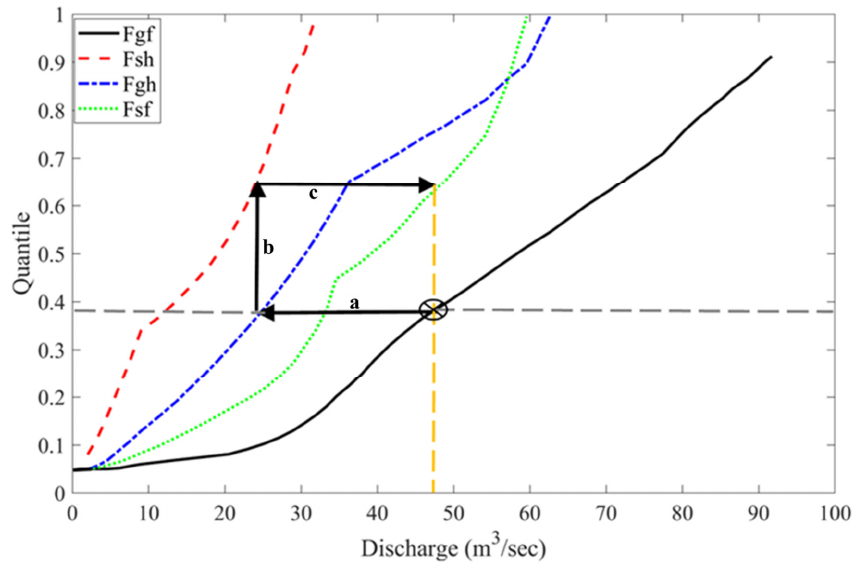
Figure 3. Illustrative figure showing bias correction using CDF-t methods.